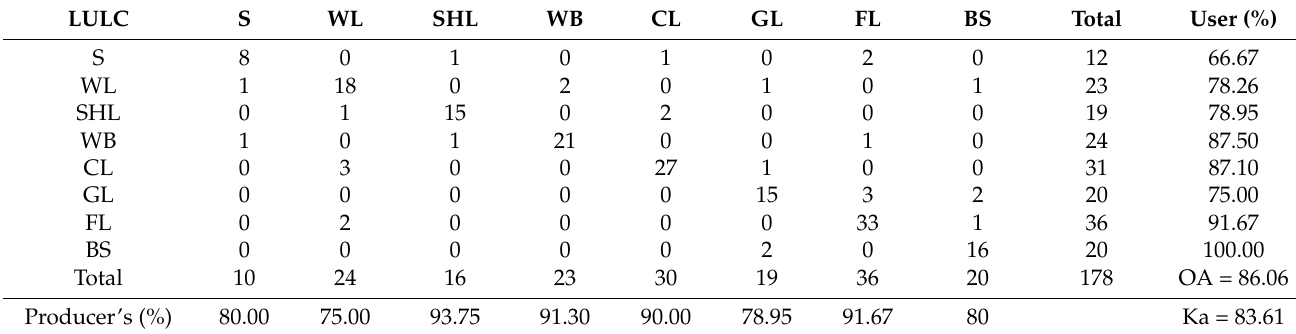
the minimum accuracy assessment criteria. The user’s accuracy (error of commission or inclusion) and producers’ (error of omission or exclusion) which are used to evaluate the classification accuracy were also calculated. Table 8. Confusion matrix of LULC in 1994 (S: Settlement; WL: Water body; SHL: Shrub land; CL: Cultivated land; GL: Grassland; FL: Forest land; BS: Bare soil).